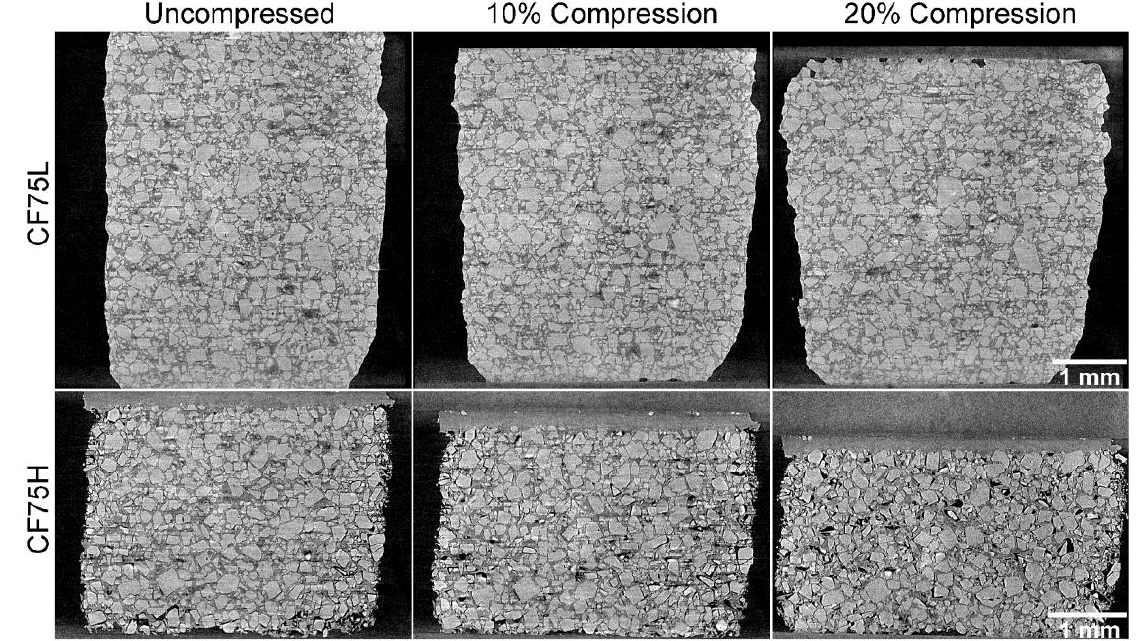
Figure 4. CT images of CF75L and CF75H samples under uniaxial compression. Note that CF75L does not show cracking, but mostly flow. CF75H shows a separation of the binder from the crystals.